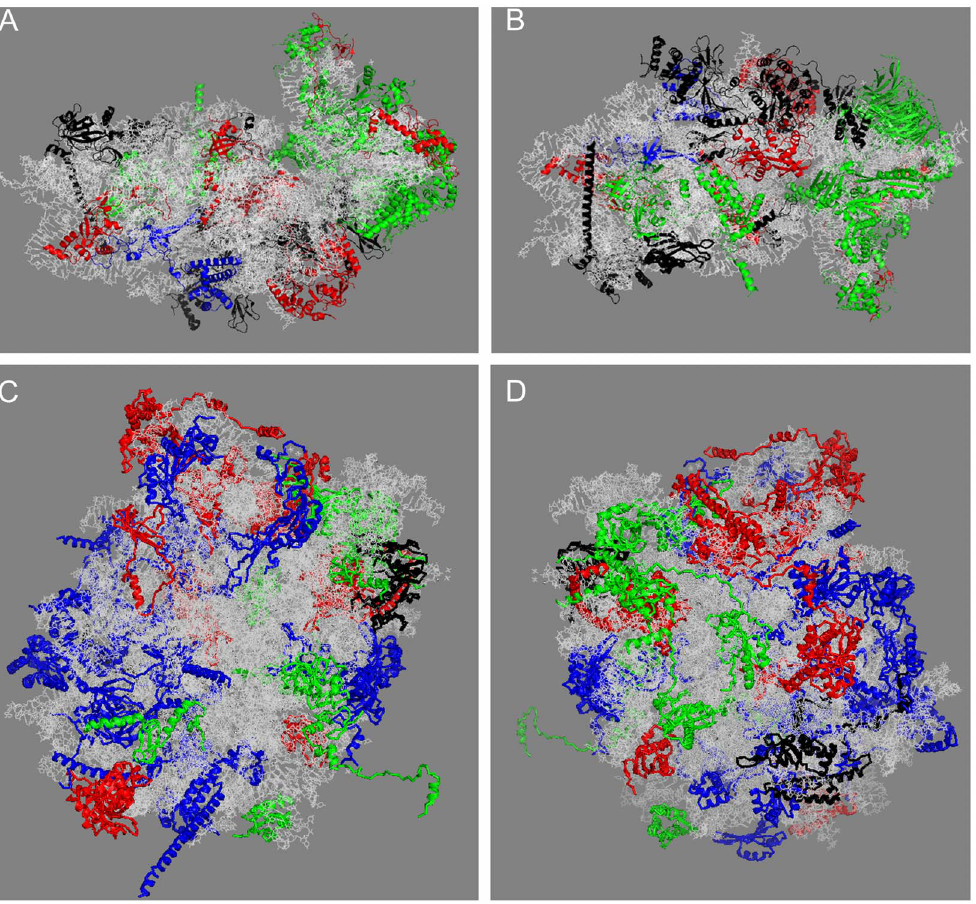
Figure 3. Modeling of split and core proteins in the 3D structure of yeast ribosome subunits. The structures were generated by PyMol using co-ordinates from [1] ( A ) 40S subunit, interface view; ( B ) 40S subunit, solvent side view; ( C ) 60S subunit, interface view; ( D ) 60S subunit, solvent side view. rRNA is shown in gray. Proteins are grouped according to their amount in the core fraction at 0.5 M LiCl. Group A (blue) – 75–100%, B (red) – 48–75%, C (green) – 22–48% and D (black) – 0–22% in the core.